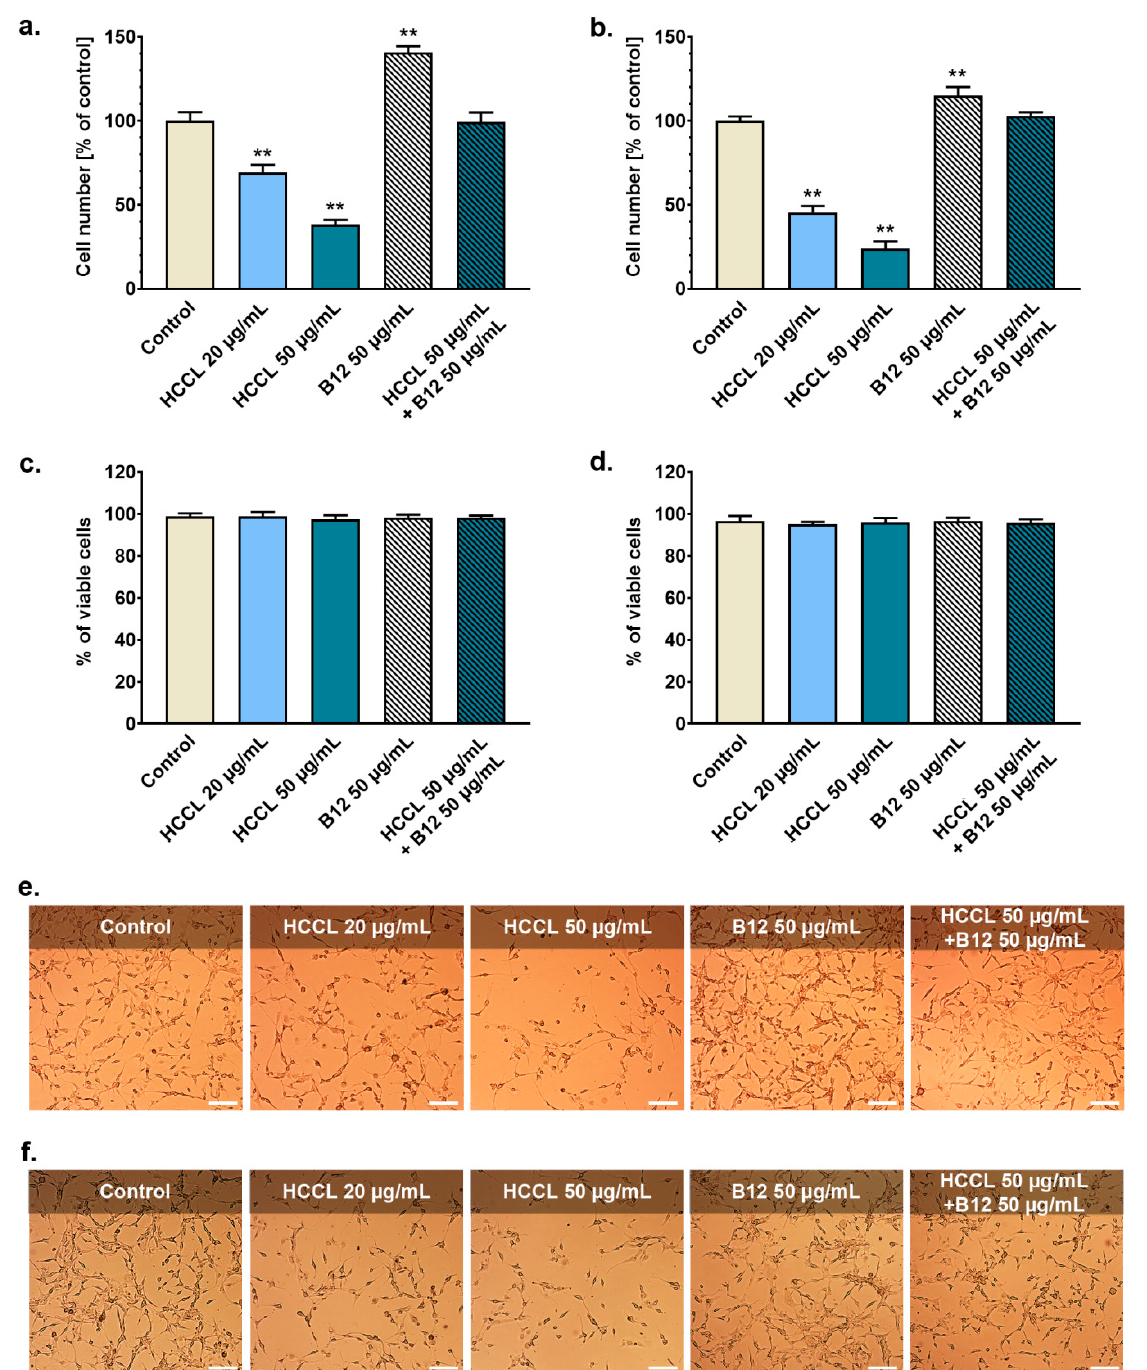
Figure 1. Effect of long-term treatment with B12 antagonist on glioblastoma cells proliferation and viability. U-87 MG cells were cultured with hydroxycobalamin [ c -lactam] (HCCL) at concentrations of 20 and 50 µ g/mL or with vitamin B12 (B12) at a concentration of 50 µ g/mL or with HCCL (50 µ g/mL) in combination with B12 (50 µ g/mL). Untreated cells were cultured in parallel as a control. Results from cell counting on day 9 ( a ) and day 18 ( b ) of the treatment were presented as % of control. Simultaneously, cell viability was assessed after 9 days ( c ) and 18 days ( d ) of culturing. Bars represent mean and SD of three independent experiments in at least triplicate; ** p < 0.005 vs. control. Representative microscope images of cells exposed to indicated conditions for 9 days ( e ) and 18 days ( f ); images obtained using light inverted microscope; scale bar = 250 µ m.